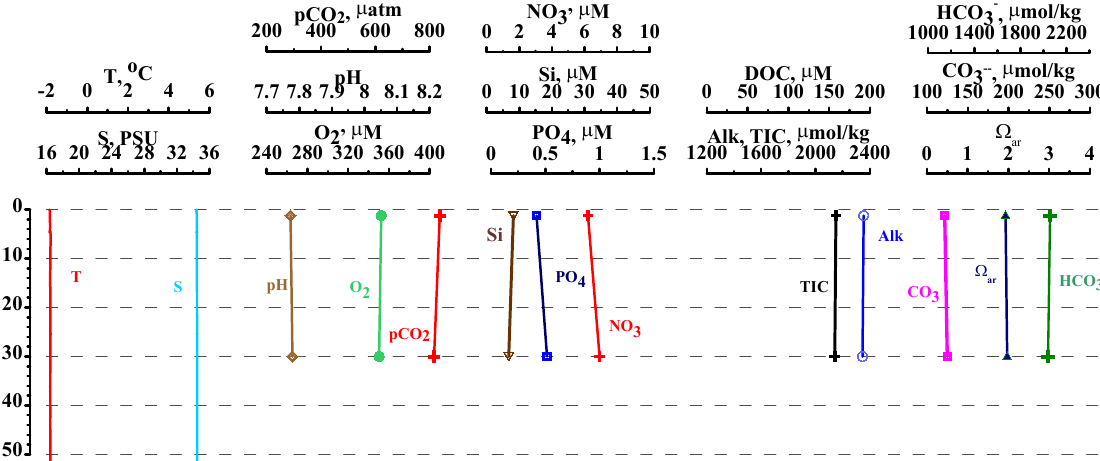
Figure A9. Vertical distribution of physical and chemical parameters at station TF4 (14 June 2017).